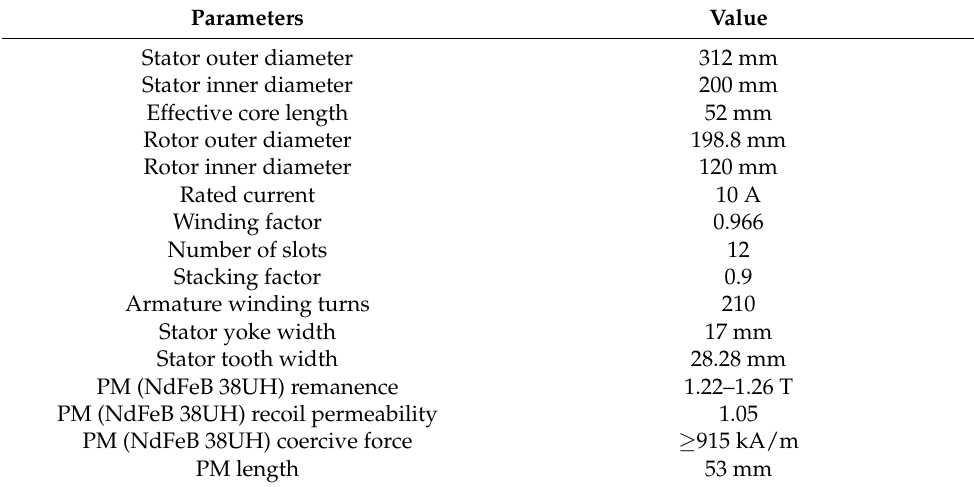
Table 1. Parameters of generator model by initial